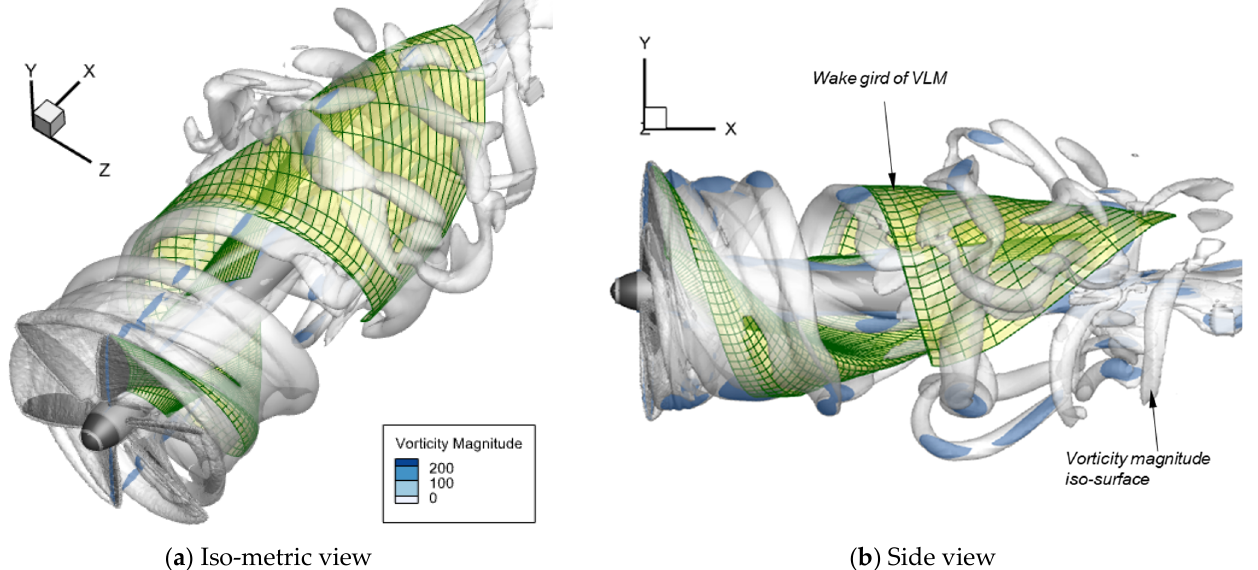
Figure 19. Propeller wake with an iso-surface of vorticity magnitude calculated by the RANS simulations, and wake panel calculated by the VLM at variable pitch angle = 34° and advanced ratio = 0.32.